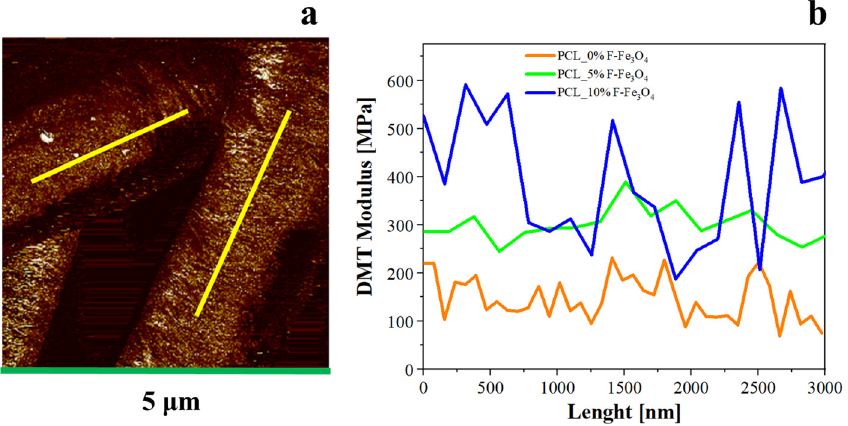
Figure 5. ( a ) H-AFM image of PCL membranes loaded with magnetite (5%). DMT Modulus profiles have been taken along the fi bre length (see yellow lines). ( b ) Comparison of the DMT Modulus pro- fi les along the fi bre lengths for the analysed samples.